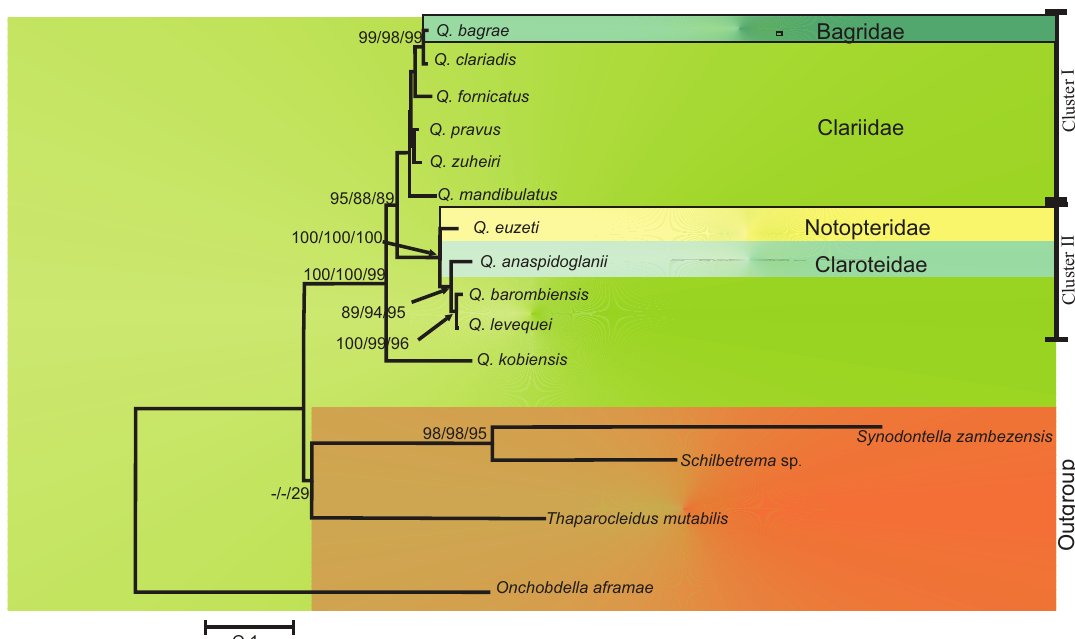
Figure 6. Consensus tree based on Neighbor-Joining, Maximum Parsimony and Maximum Likelihood for 28S rDNA (616 bp). Numbers indicated above the branches correspond to bootstrap values NJ/MP/ML, respectively obtained after 1000 iterations.